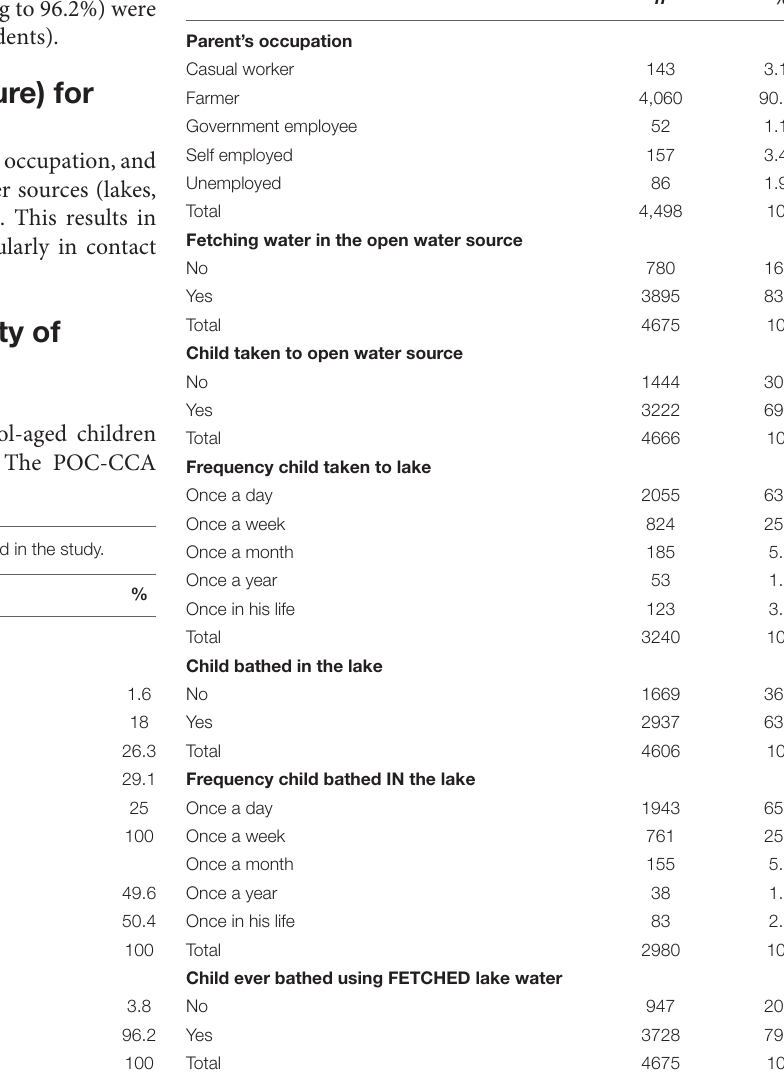
TABLE 2 | Water contact activities for parents and their children in the study